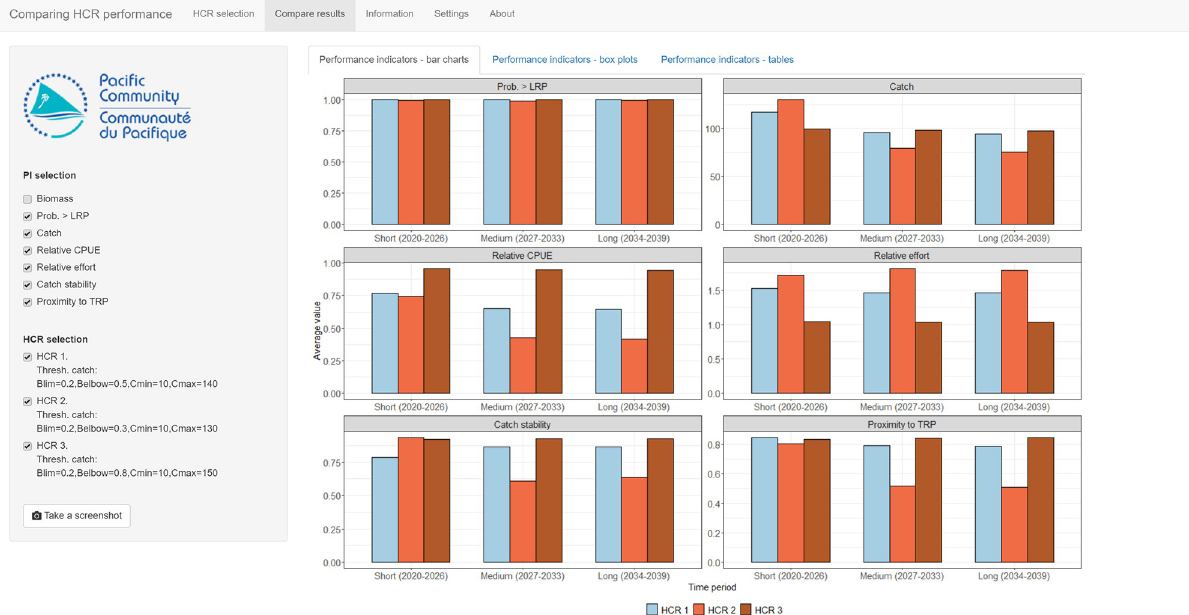
Fig 5. A screenshot of the compare results tab in the Comparing performance app. In this example, three HCRs have been tested and added to the basket of candidate HCRs. Each panel shows the median value of a performance indicator in each time period (short-, medium- and long-term) for each HCR. Here, the biomass indicator has been deselected leaving the remaining six indicators. Various trade-offs can be seen. For example, HCR 2 has the highest median catches in the short-term, but the lowest catches in the medium- and long-term.